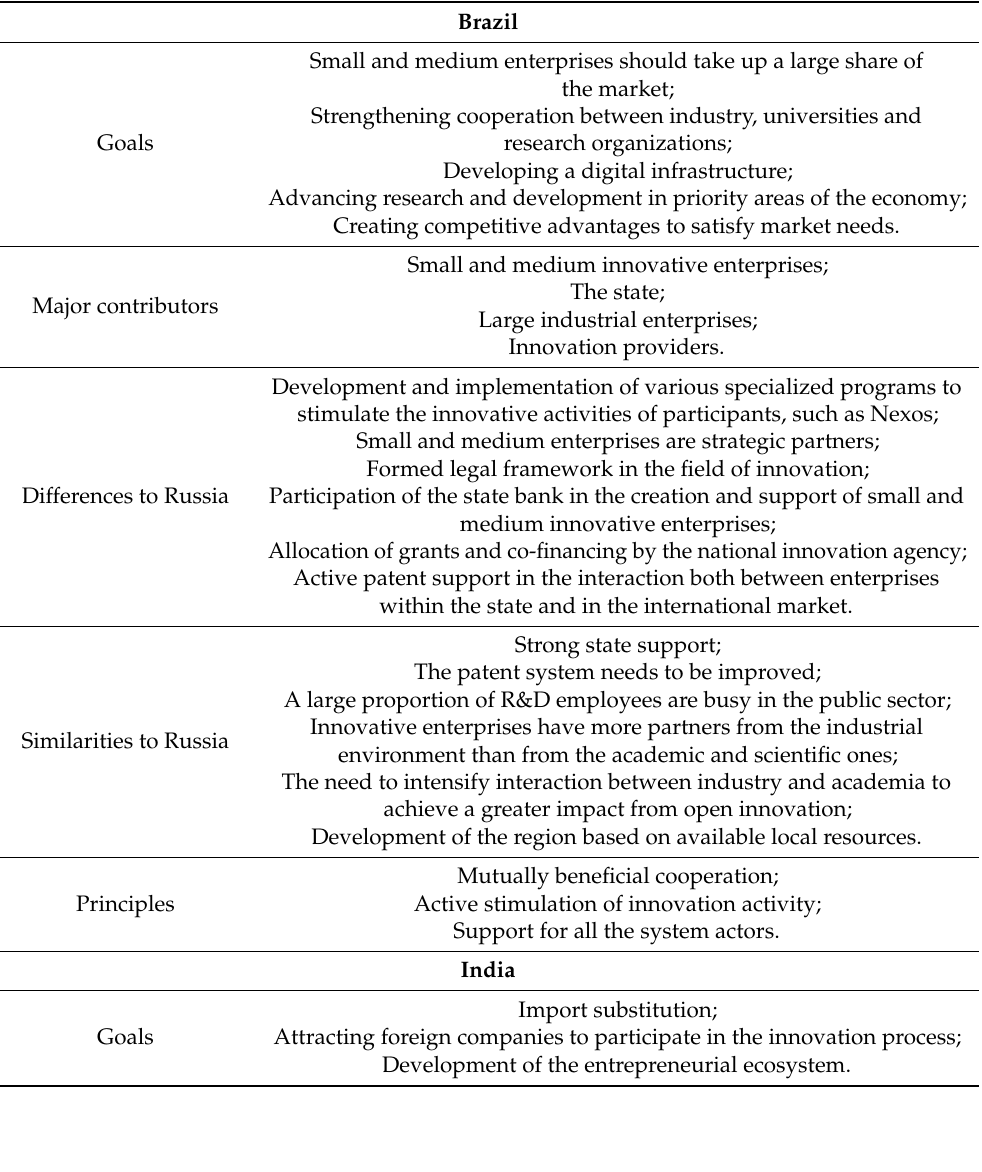
Table 3. Characteristics of the innovation activity in Brazil, India and Canada; the data have been adapted from Refs.